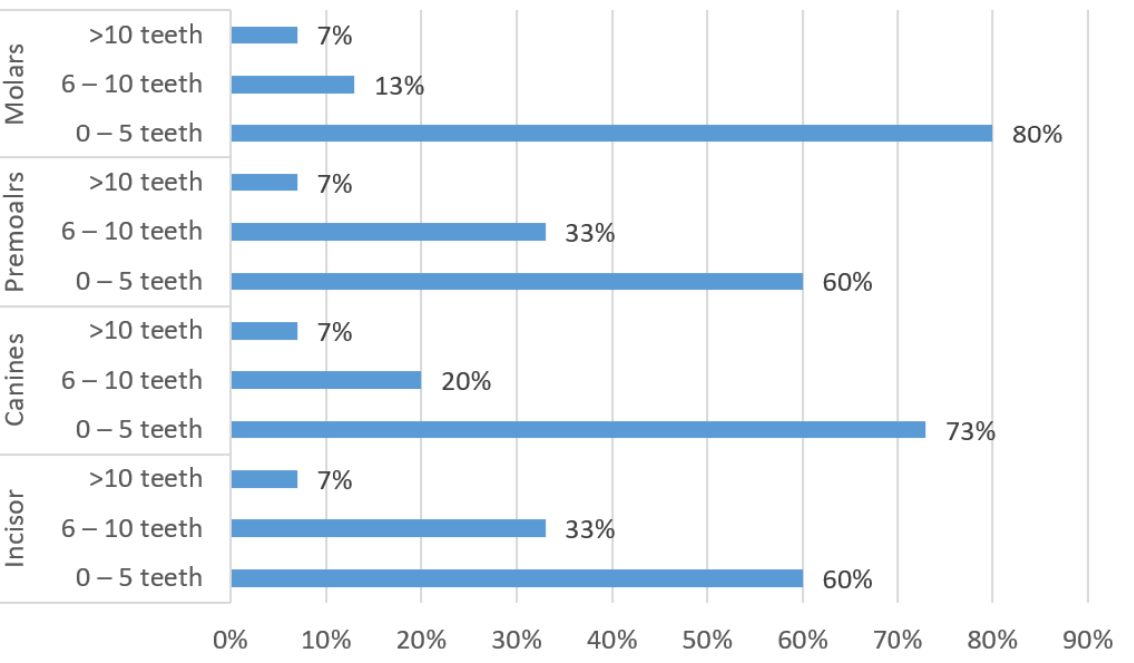
Figure 3. Number of RCT teeth to be completed before graduation (including preclinical and clinical training).